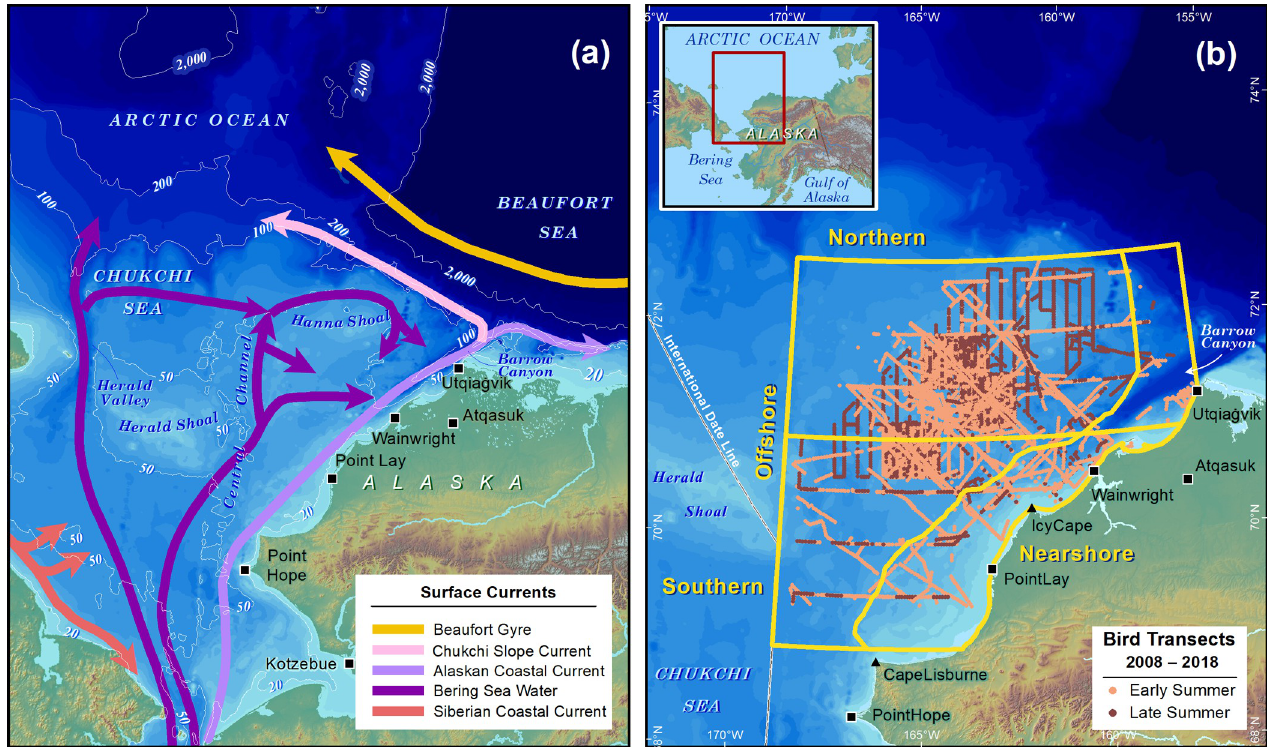
Fig 1. The Chukchi Sea, showing (a) current locations; and (b) geographic strata and survey effort. Bathymetry data are from the International Bathymetric Chart of the Arctic Ocean www.ibcao.org.